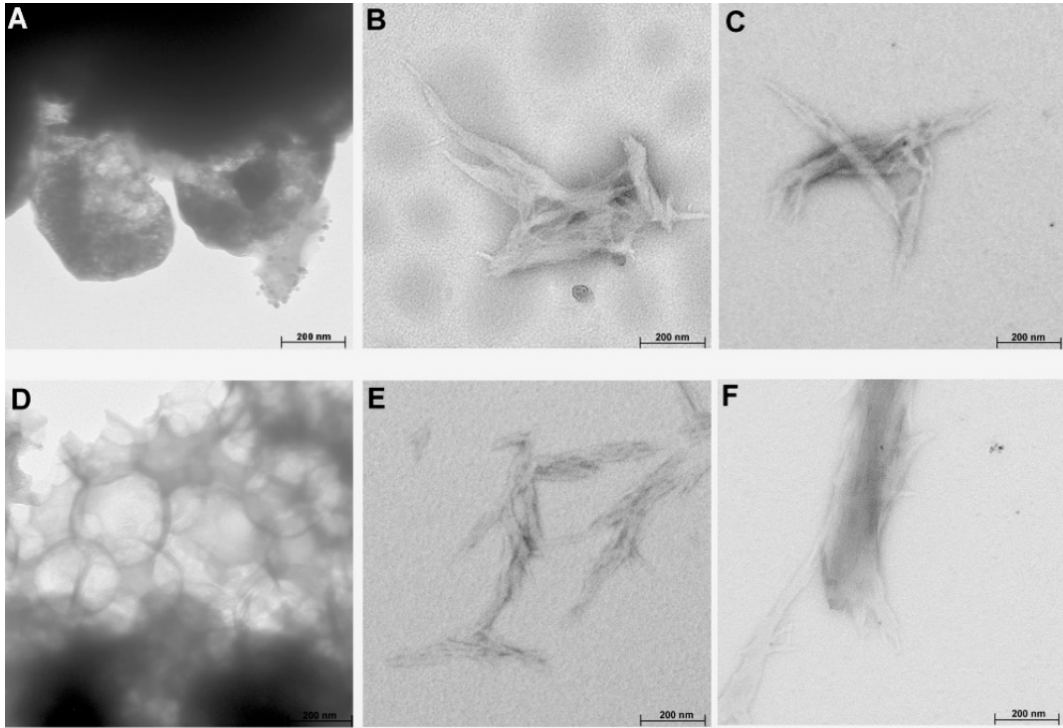
Figure 6. TEM images of ( A ) Avicel, ( B ) Avicel treated with [EMIM][Cl], ( C ) Avicel treated with [PMIM][Cl], ( D ) Sigmacell, ( E ) Sigmacell treated with [EMIM][Cl], and ( F ) Sigmacell treated with [PMIM][Cl].